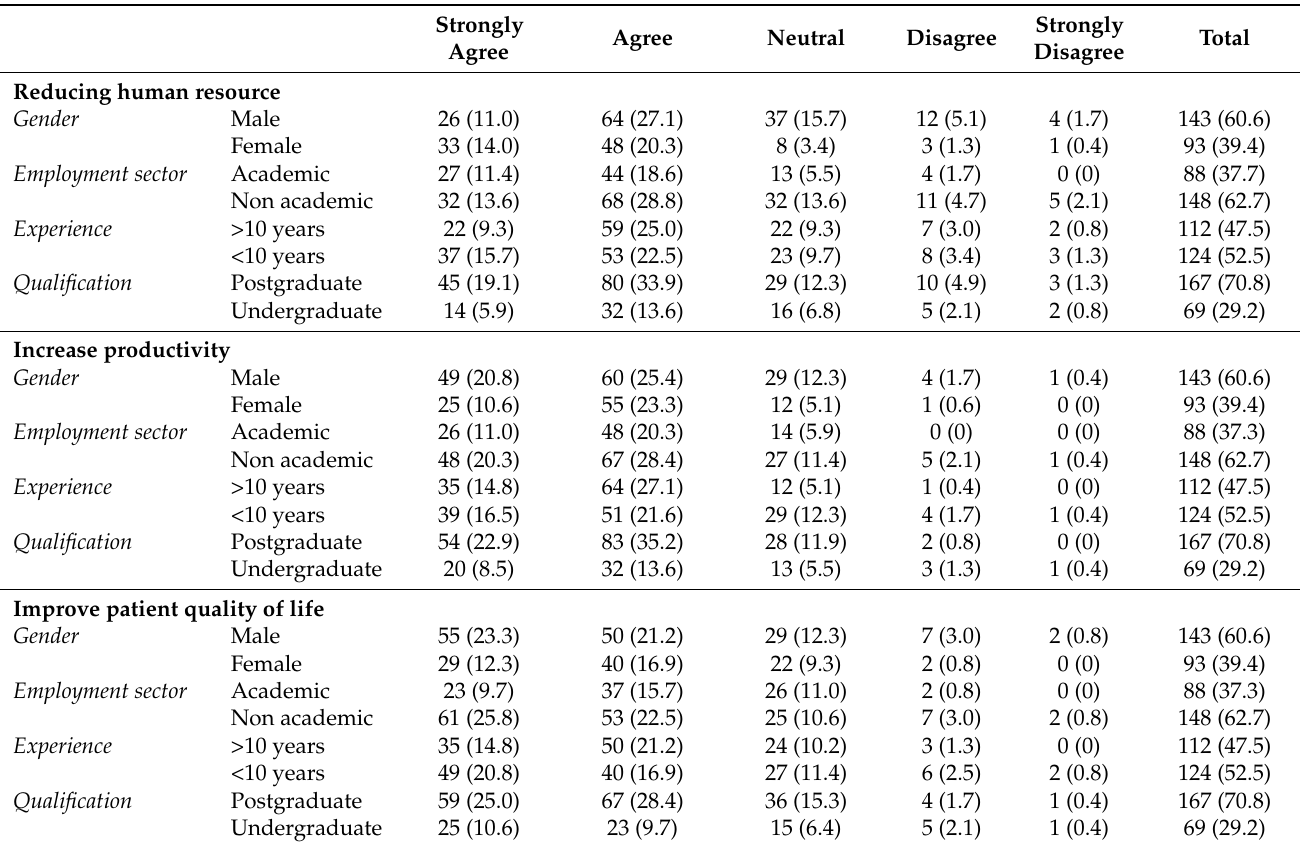
Table 6. Participants attitudes toward the impact of AI on rehabilitation